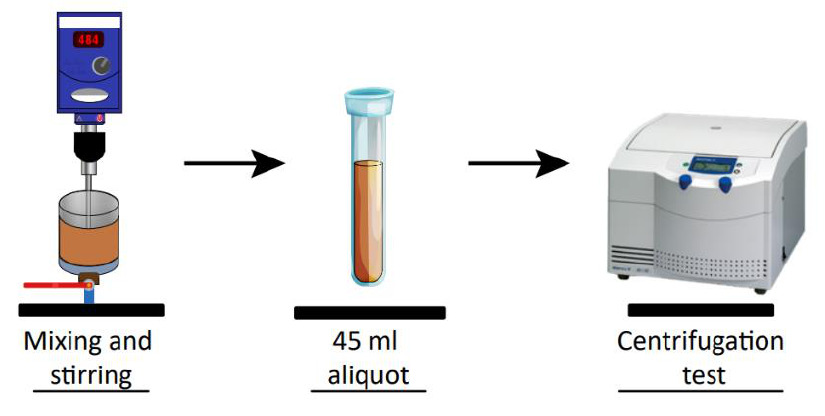
Figure 4. Schematic representation of the experimental setup for the centrifugation assays.